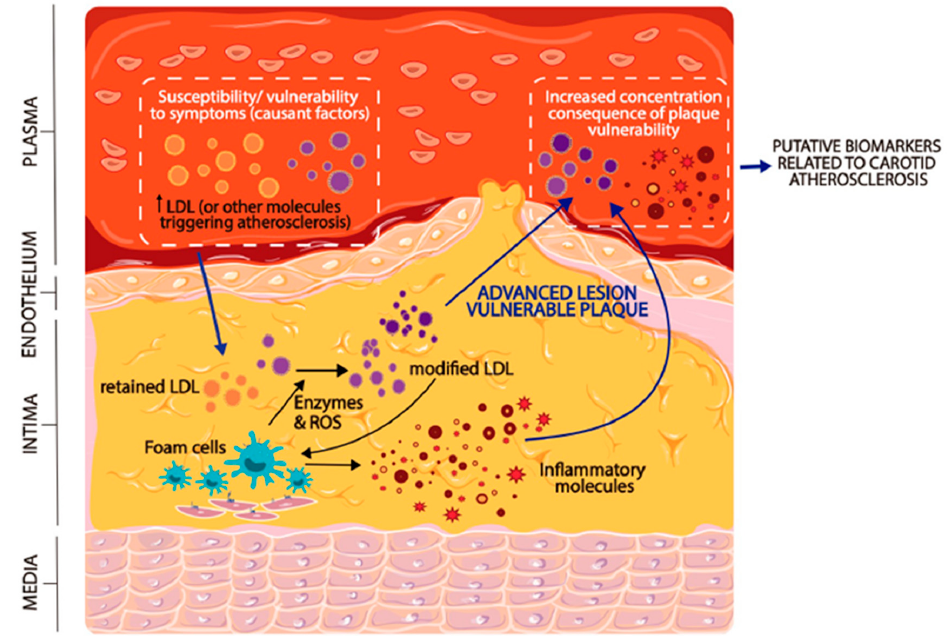
Figure 2. Presence of circulating biomarkers in patients with carotid atherosclerosis. Some molecules